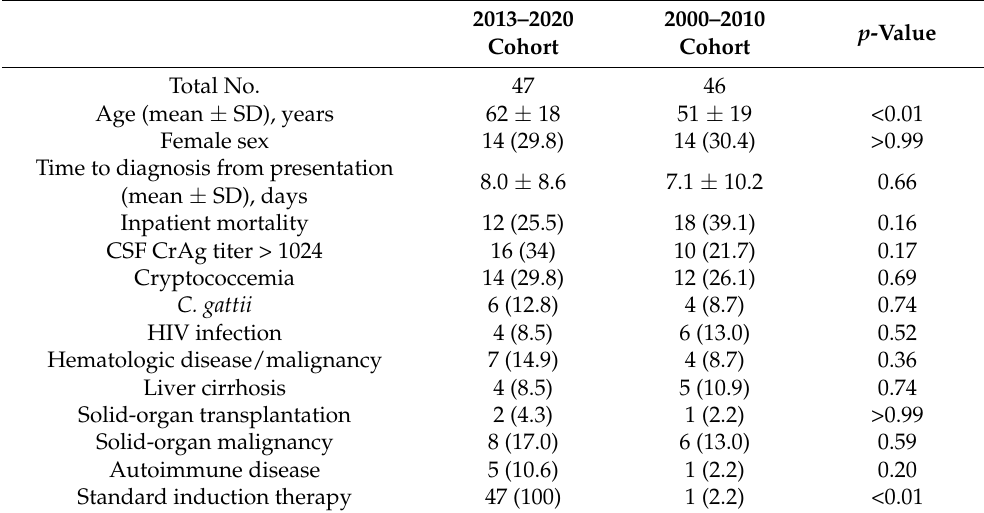
Table 4. Comparisons of demographic and clinical characteristics of two cohorts with cryptococcal